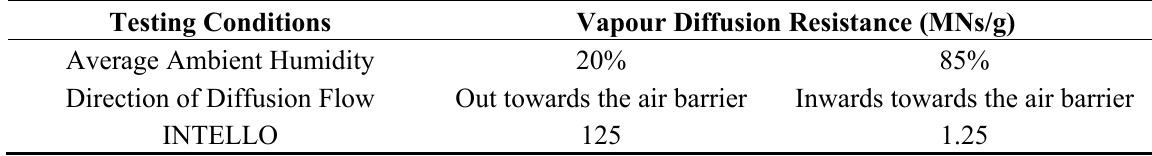
Figure 6. Construction detail—roof. Table 3. Vapour diffusion resistance of the INTELLO membrane